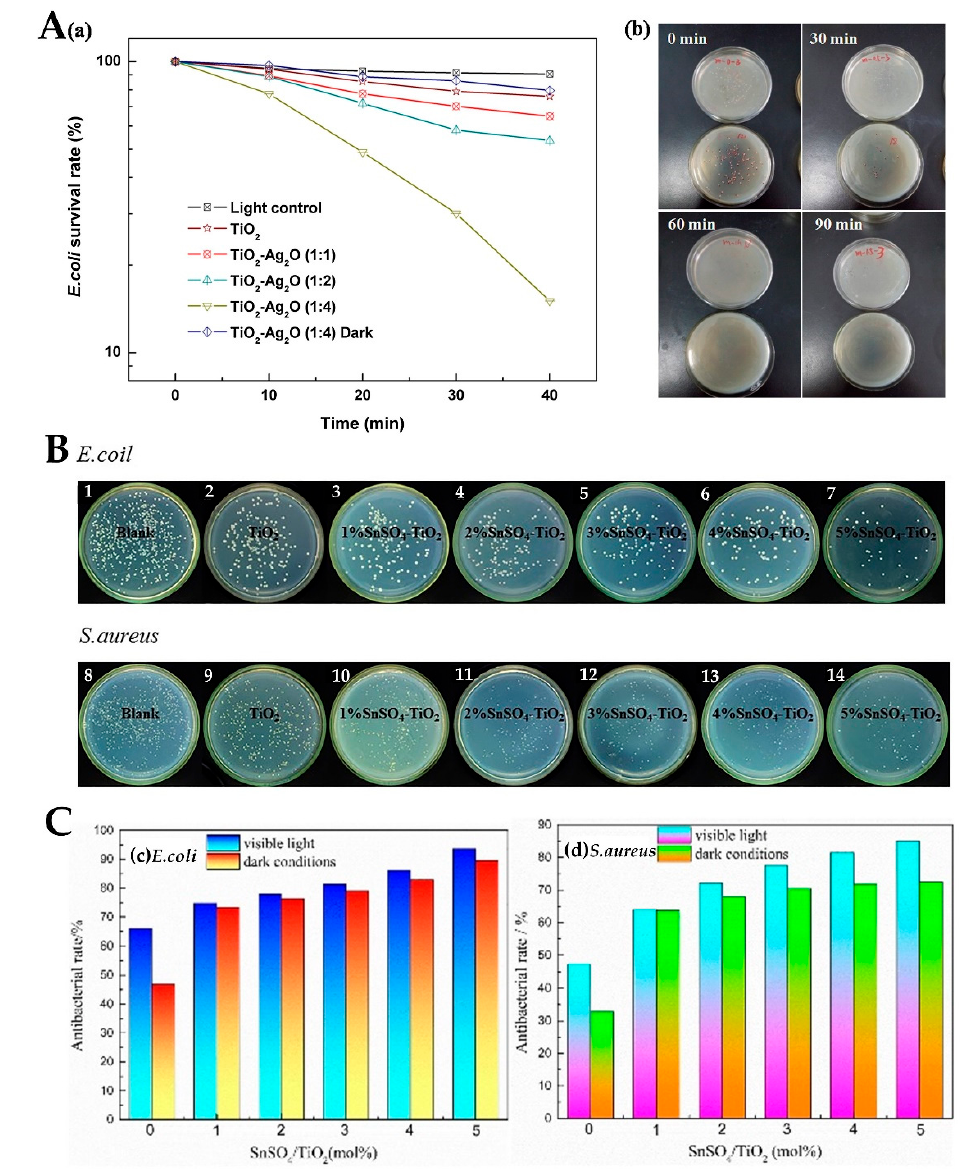
Figure 9. ( A ) Photocatalytic antibacterial efficiency toward E. coli with photocatalysts under visible light ( a ) and antibacterial effect of TiO 2 /Ag 2 O (1: 4) on E. coli under visible light ( b ) [85]; ( B ) antibac- terial activity of different samples against E. coli ( 1 – 7 ) and S. aureus ( 8 – 14 ); ( C ) antibacterial activity of different samples against E. coli ( c ) and antibacterial activity of pure TiO 2 and xSnSO 4 -TiO 2 against S. aureus in the presence/absence of visible light ( d ) [88]. Table 2. Antimicrobial effect of different TiO 2 materials under visible light.